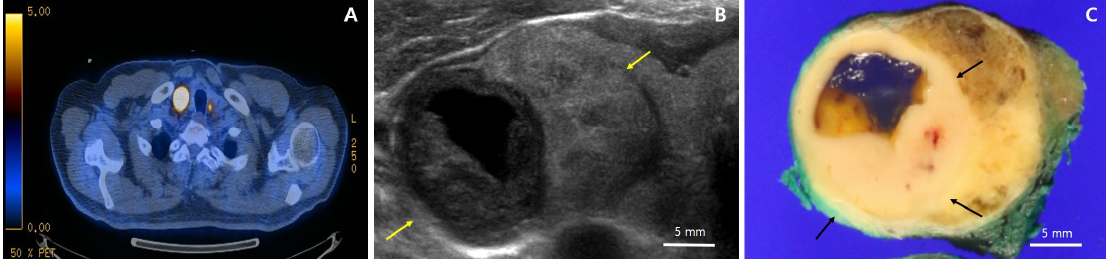
Figure 1. 18 F-fluorodeosy-glucose positron tomography (FDG-PET), ultrasound, and gross photos. ( A ) FDG-PET showing a hypermetabolic mass (SUVmax = 76.5) in the right thyroid as well as a focal hypermetabolic lesion (SUVmas = 7.7) in the left thyroid; ( B ) Ultrasound of the right lobe showing a 3.4 cm isoechoic solid nodule with regular margins (yellow arrows), accompanied by a 2.1 cm hypoechoic solid nodule with cystic changes and “nodule in nodule” pattern. In contrast to the larger nodule, the smaller hypoechoic solid nodule is taller than it is wide; ( C ) Gross photo showing a tumor with the largest diameter of 3.2 cm circumscribed by a thin capsule; a distinctive 1.5 × 1.4 cm light yellowish to white homogeneous solid portion (black arrows) with partial cystic changes and smooth borders within a tan to brown mass.